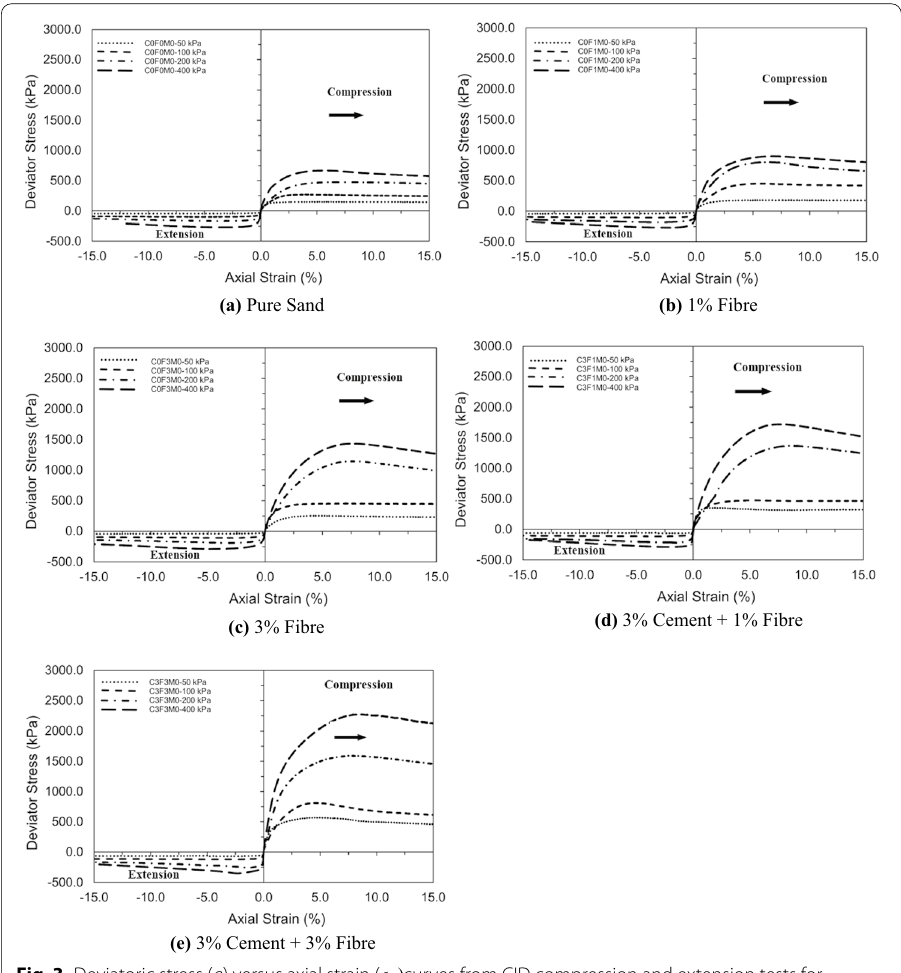
Fig. 3 Deviatoric stress ( q ) versus axial strain ( ǫ a ) curves from CID compression and extension tests for unreinforced, fibre, and fibre reinforced cemented Toyoura sand specimens consolidated to varying mean effective stresses ( p’ ) a Pure sand b 1% fibre c 3% fibre d 3% cement